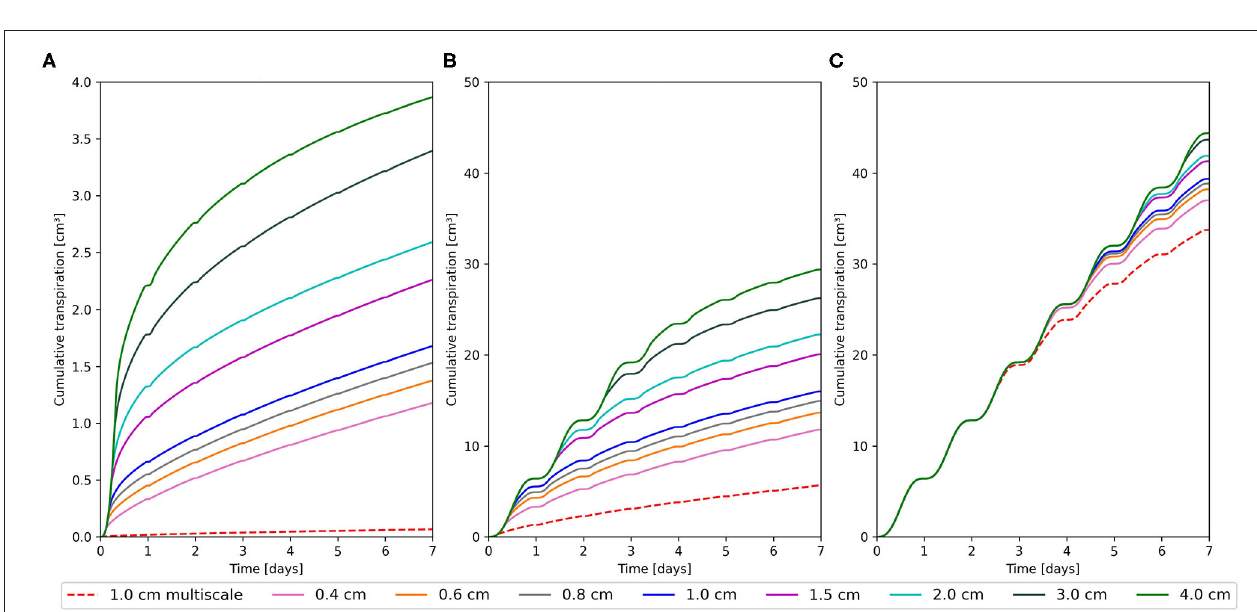
FIGURE 2 | Cumulative transpiration at different soil grid resolutions for the root system scale (RSS) model (solid) and the multi-scale model (dashed). (A) Sand at ψ s , top = − 100 cm, (B) Loam at ψ s , top = − 659.8 cm, and (C) Clay at ψ s , top = − 659.8 cm.